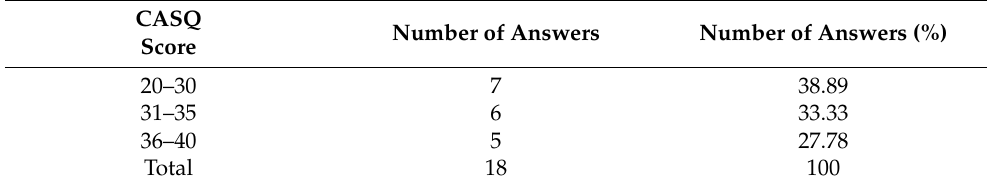
Table 7. Percentile repartition of values for CASQ score in score intervals.